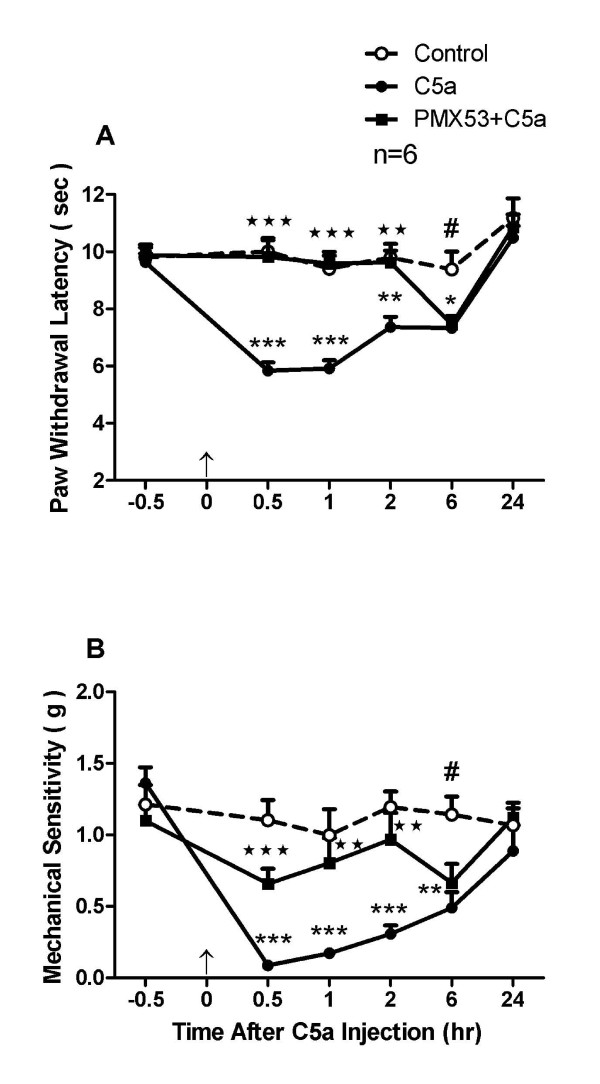
Pre-treatment with PMX53 (3 mg/kg) abolished the heat hyperalgesia (A) and mechanical allodynia (B) induced by intraplantar injection of recombinant mouse C5a (200 ng). Values are expressed as mean ± SEM, *, P < 0.05, **, P < 0.01 or ***, P < 0.001 (comparison of C5a group and saline group); #, P < 0.05 (comparison of PMX53 group and saline group); ⋆⋆, P < 0.01 and ⋆⋆⋆, P < 0.001 (comparison of PMX53 and C5a groups). An arrow head at time = 0 indicates C5aR agonist injection.